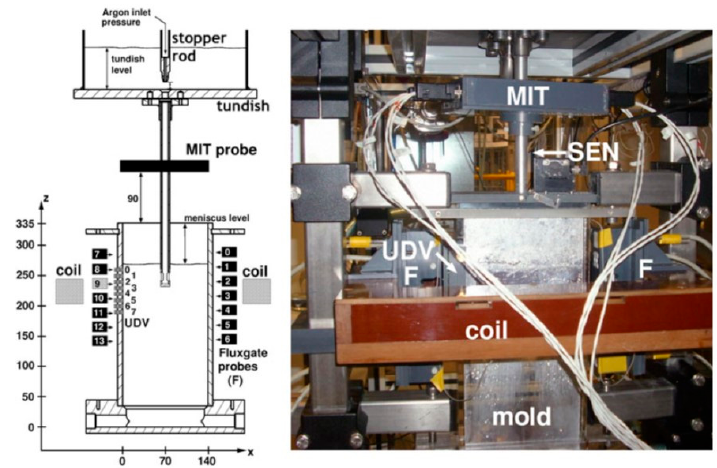
Figure 6. Low melting alloy (Ga 68 In 20 Sn 12 ) in 0.4-scale model of slab casting [87].